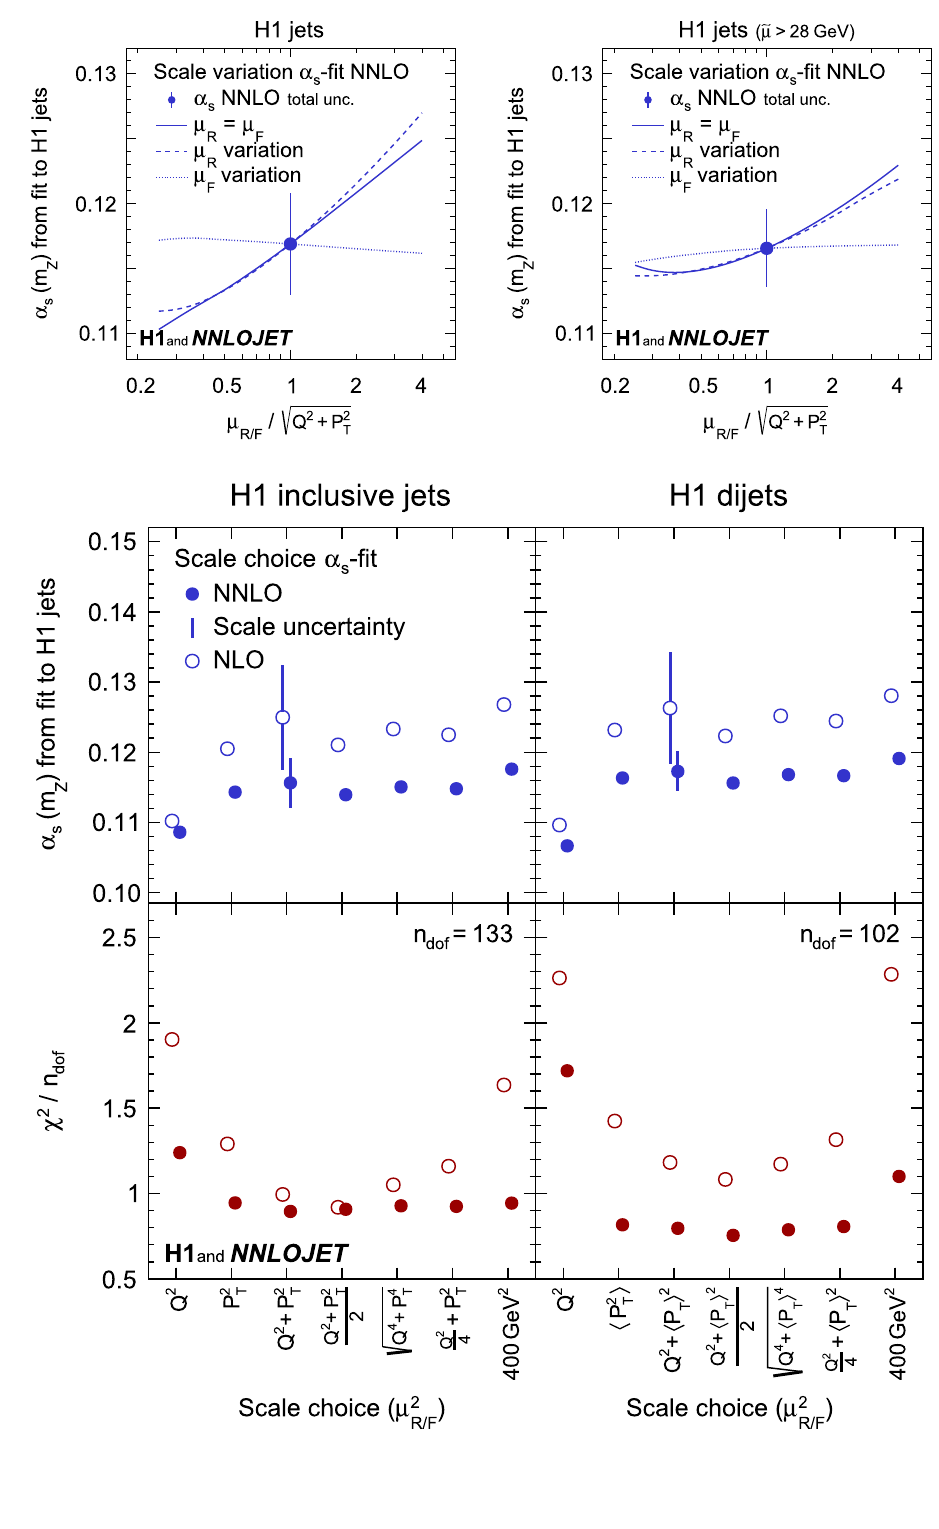
Fig. 7 Dependencies of the fitted values of α s ( m Z ) as a function of the scale factors for the H1 jets fit (left) and the H1 jets fit with ˜ μ > 28GeV (right).